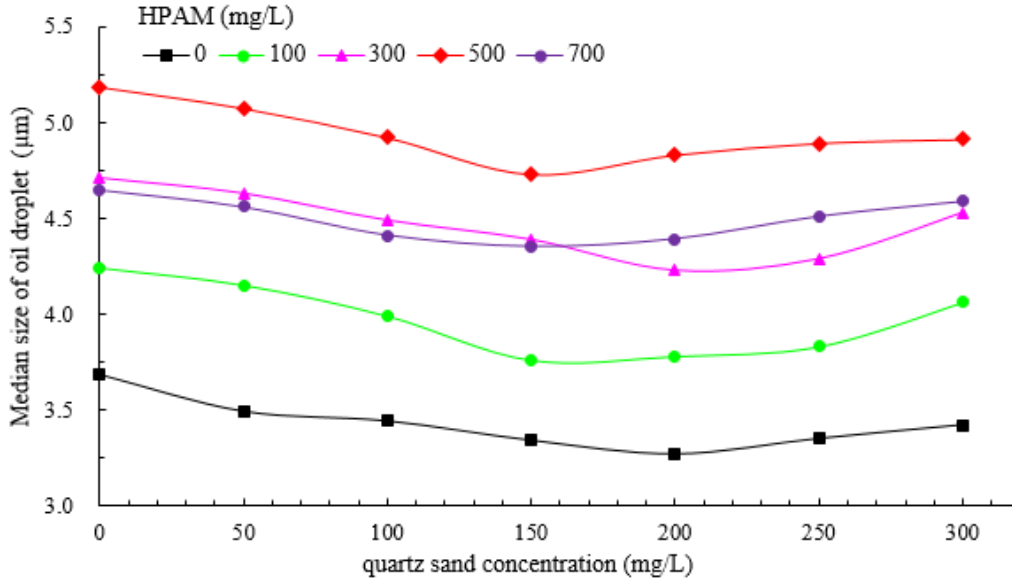
Figure 14. The synergetic effect of quartz sand particles and polymer on oil droplet size (alkali concentration 600 mg/L, surfactant concentration 200 mg/L).